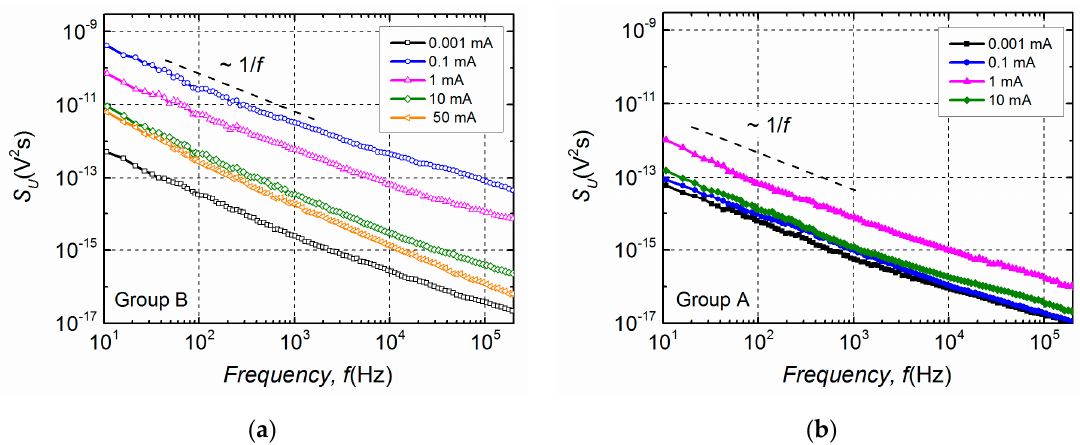
Figure 5. Electrical noise spectra S U of the group B LD ( a ) at different current values in the whole investigated forward current range and of the group A LD ( b ) at different forward current values up to the second bump appearance (presented in Figure 4).